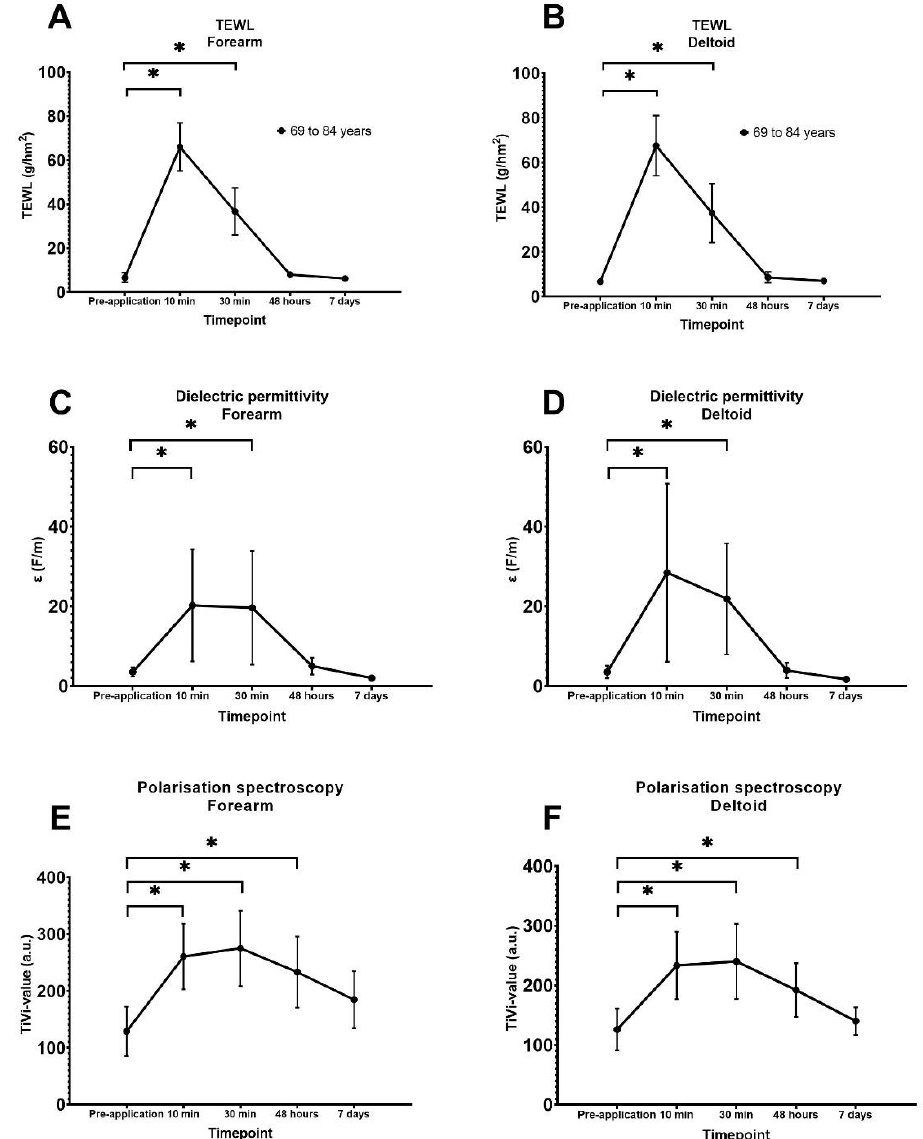
Figure 3. Graphs of mean values and standard deviation after measurement by evaporimetry (transepidermal water loss (TEWL)), dielectric permittivity, and polarisation spectroscopy (TiVi values) during the timepoints; pre-application, 10 min ( n = 12), 30 min ( n = 12), 48 h ( n = 12), and 7 days ( n = 4) after HD-MAP application. Explanations for subfigures: ( A )—Forearm